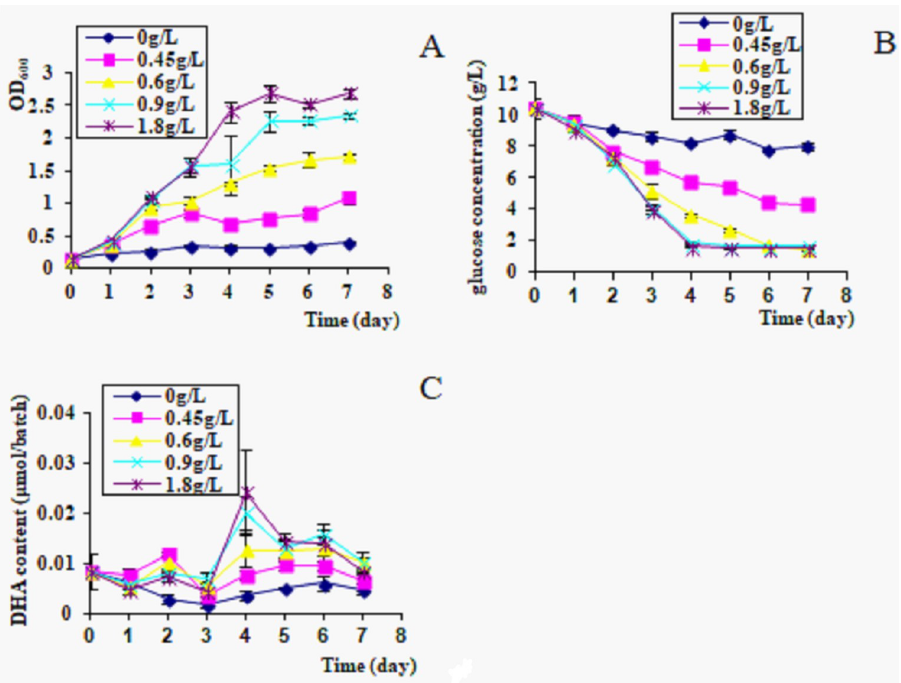
Fig 2. Growth rate and DHA production in different glutamate concentrations. A, OD 600 ; B, glucose consumption; C, DHA content in culture, 300 μ l/batch.